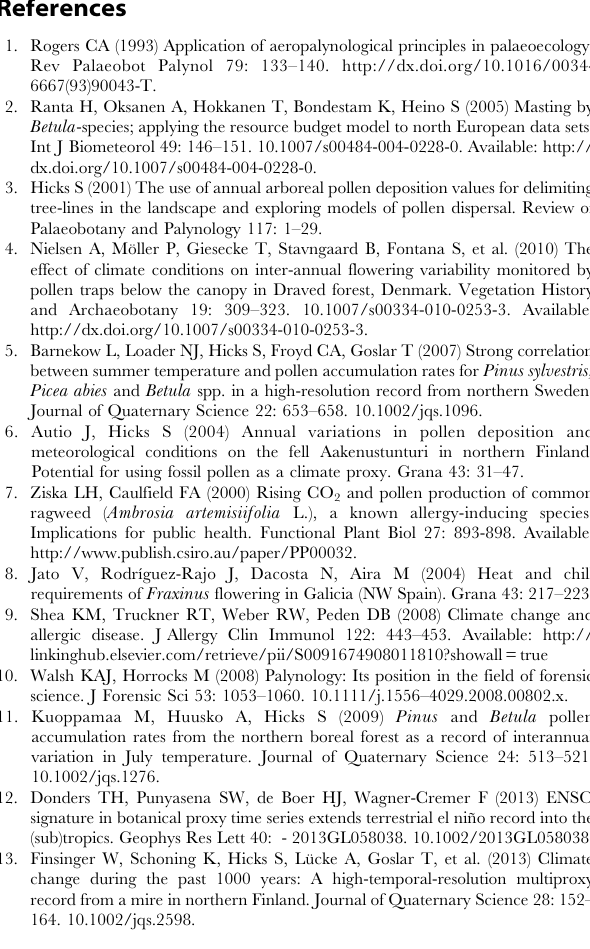
Table S6. Temperature in the year before flowering. Table S7. Precipitation in the flowering year. Table S8. Precipitation in the year before